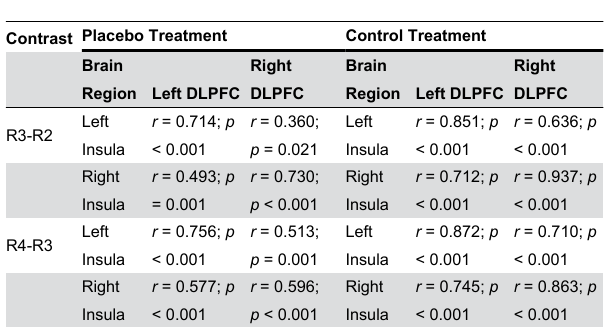
Table 4. Results of correlations between change in alpha power in the ROIs defining the bilateral DLPFC and insulae.